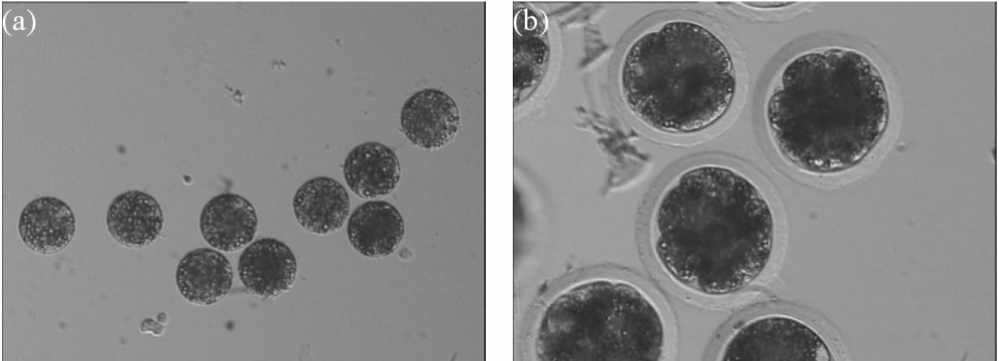
Figure 12. Enucleation results. ( a ) The removed cytoplasm and genetic material formed into spheres in the culture medium. ( b ) Embryos after oocyte enucleation, somatic cell injection, and cultured for 24